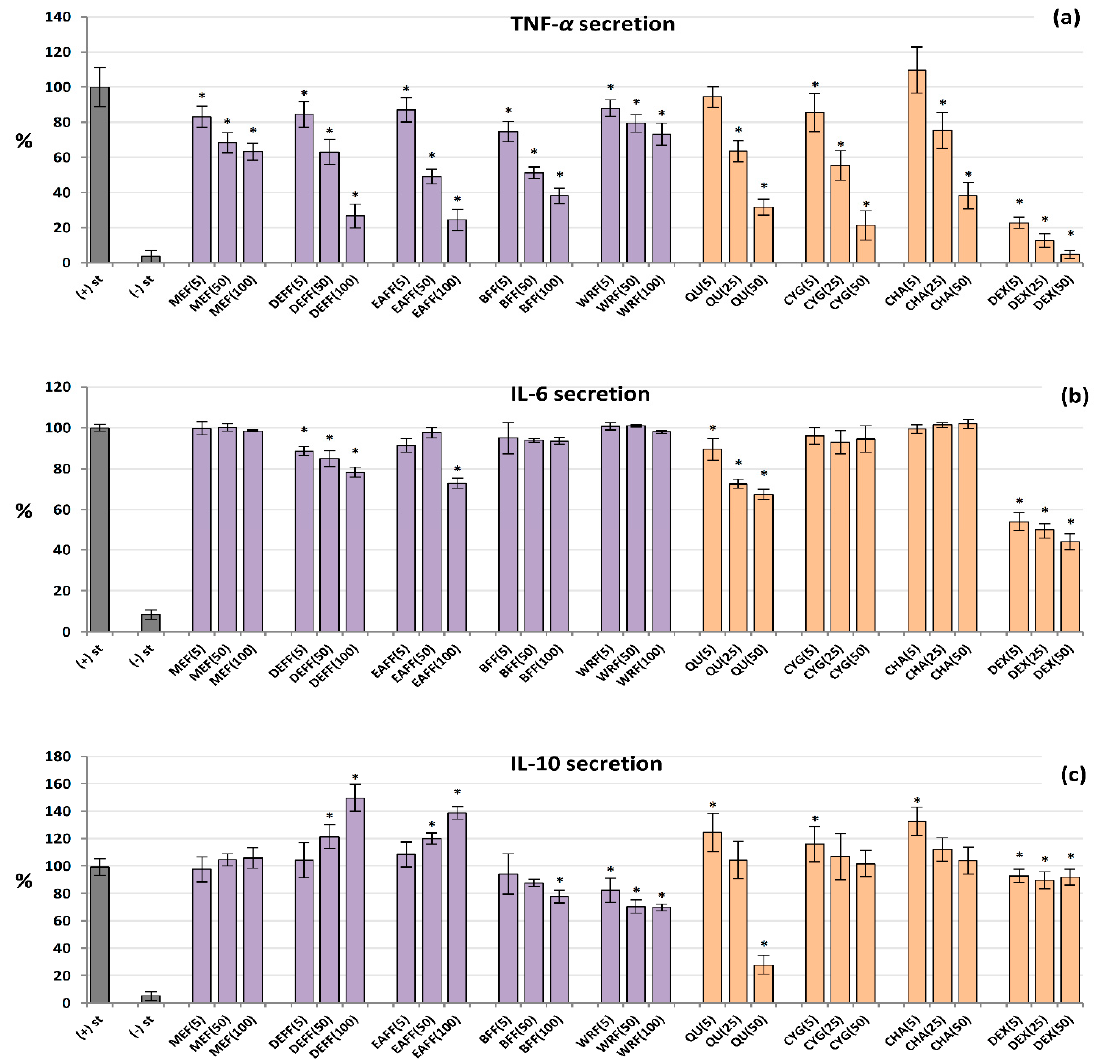
Figure 5. Effect of fruit extracts/fractions (5–100 µg/mL) and standards (5–50 µM) on pro-inflammatory and anti-inflammatory functions of stimulated human PBMCs: effects on the secretion of ( a ) TNF- α , tumour necrosis factor α ; ( b ) IL-6 interleukin 6; and ( c ) IL-10, interleukin 10. Positive control: DEX, dexamethasone. For extracts codes see Table 1. Data expressed as means ± SD of five independent experiments performed with cells isolated from five independent donors. Statistical significance in Dunnett’s test: * p < 0.05 compared with the stimulated control.